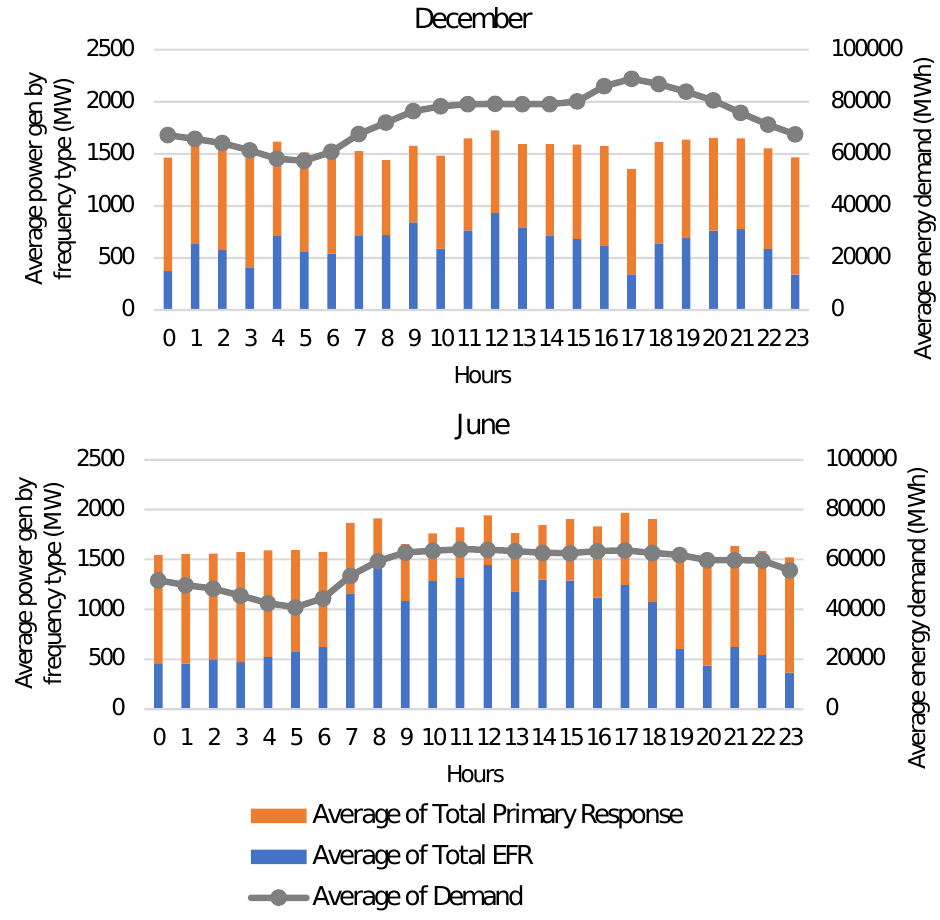
Figure 6. Summer and winter daily frequency response profiles for Case study